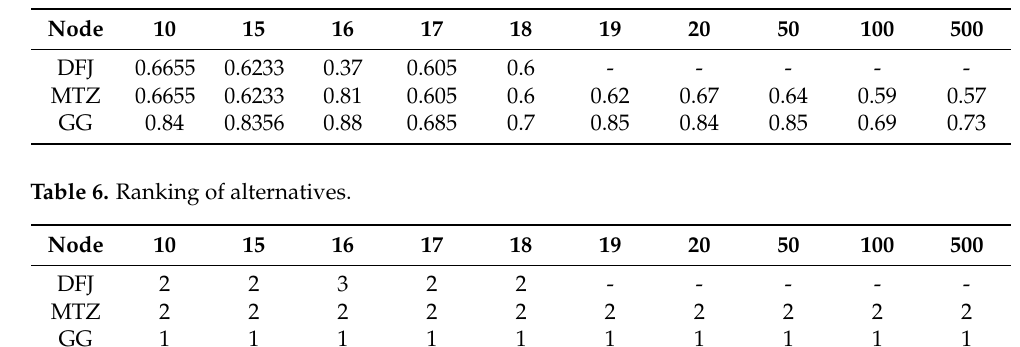
Table 5. Scoring alternatives by LINGO 11.